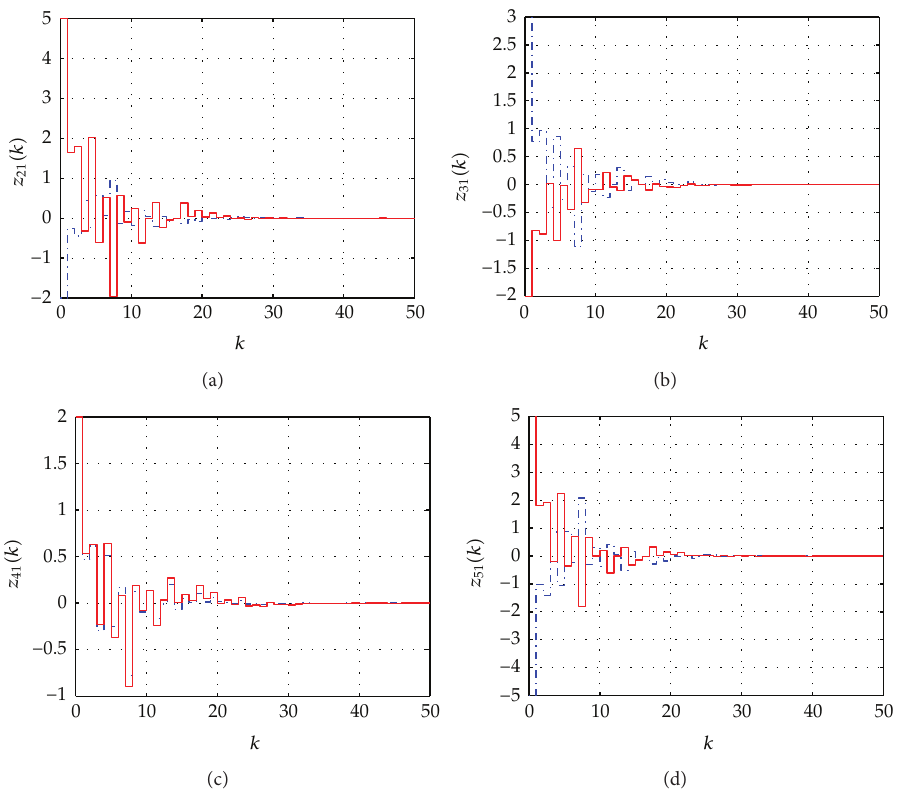
Figure 3: Synchronization errors trajectories with C1-1 ( 𝜏 = 3 ) (Example